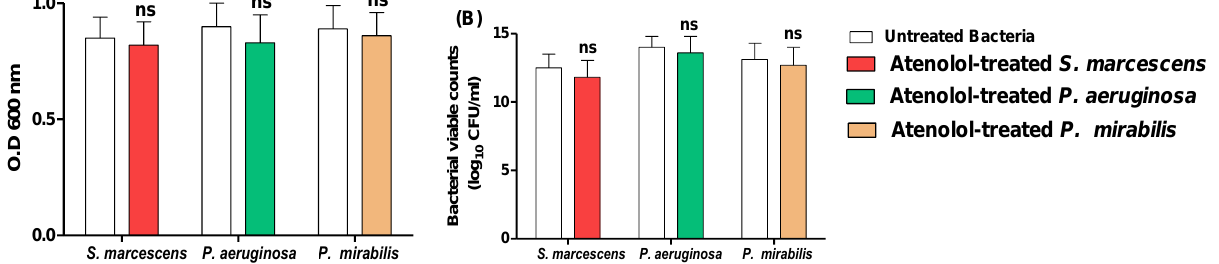
Figure 8. Effect of atenolol at sub-MIC on the bacterial growth. ( A ) The optical densities of the bacterial cultures after overnight growth in the presence or absence of atenolol at sub-MIC ( B ) The bacterial viable counts in the presence and absence of atenolol at sub-MIC. There was no significant difference between the viable counts and optical densities of untreated controls and atenolol-treated cultures. ns: nonsignificant ( p > 0.5).